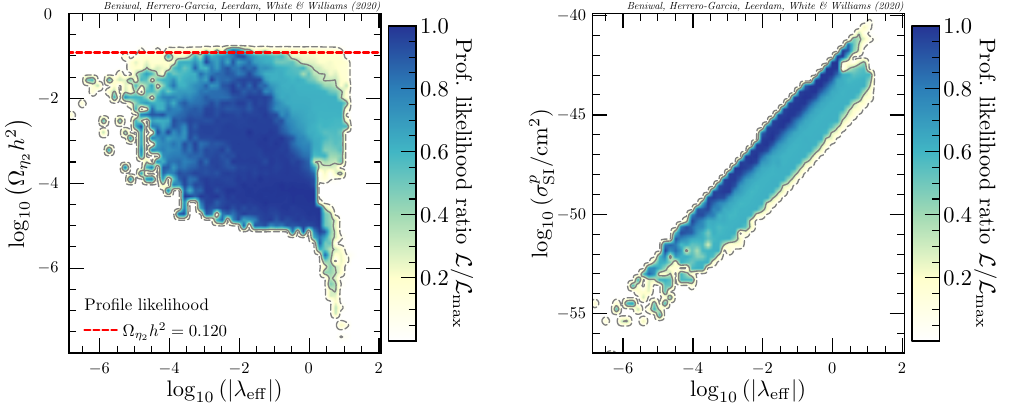
Figure 7 . 2D plots of PLR for the η 2 relic abundance ( left panel ) and SI η 2 -proton cross section ( right panel ) versus the dimensionless h - η